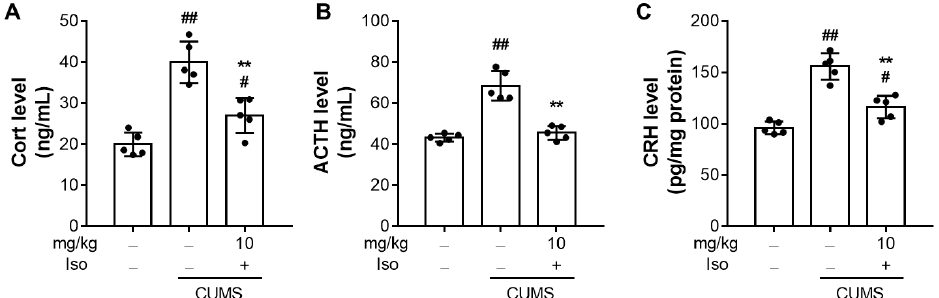
Figure 6. Isofraxidin attenuates CUMS-induced hyperactivity of the hypothalamic-pituitary-adrenal axis. ( A – C ) Levels of serum Cort ( A ) and ACTH ( B ) and hypothalamus CRH ( C ) in mice. The neuroendocrine hormones were determined by ELISA. The Cort and ACTH levels were normalized to the serum volume and the CRH level was normalized to the total protein. Data are presented as means ± SEM ( n = 5). The Control group was CUMS-free mice administered with normal saline. CUMS group was CUMS mice. Significance was analyzed by one-way ANOVA followed by the Bonferroni correction. # p < 0.05 and ## p < 0.01, compared with the control group. ** p < 0.01, compared with CUMS group.